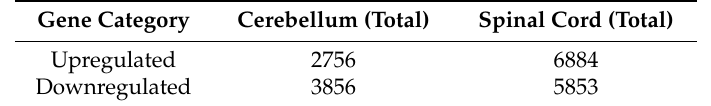
Table 2. WNV-induced gene regulation in mouse CSCs and SCSCs. Number of genes up- or downregulated. Total number of dysregulated genes.